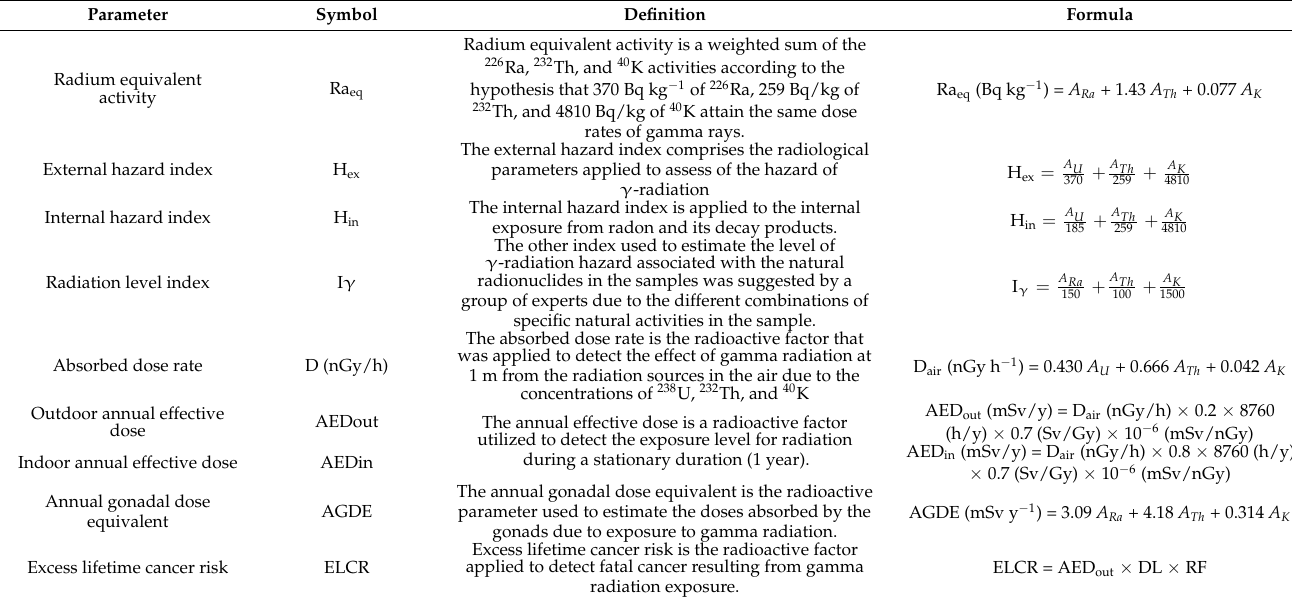
Table 1. Important radiological parameters and